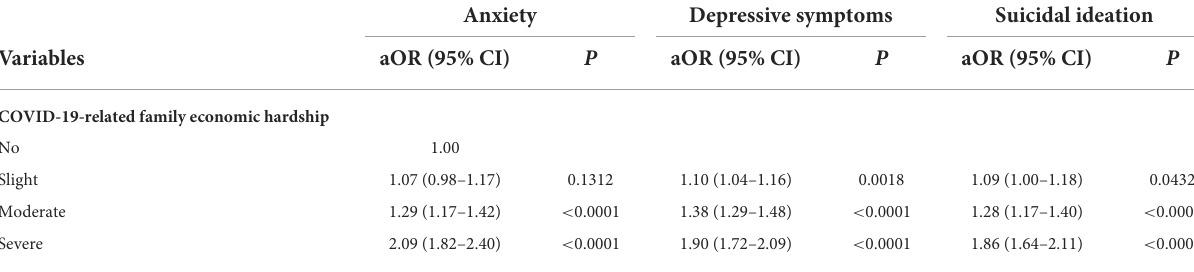
TABLE 2 Association between COVID-19-related family economic hardship and mental health ( N = 54,948). Anxiety Depressive symptoms Suicidal ideation